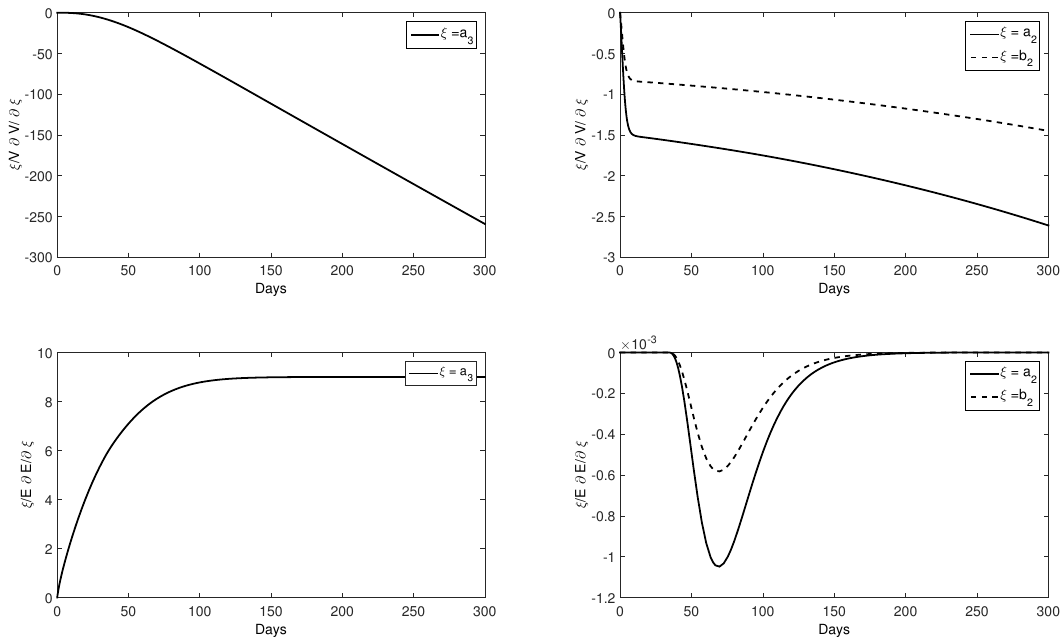
∂ V ∂ E (top row) and ξ (bottom row) for ξ = a 3 (left) and ξ = a 2 V E ∂ξ ∂ξ